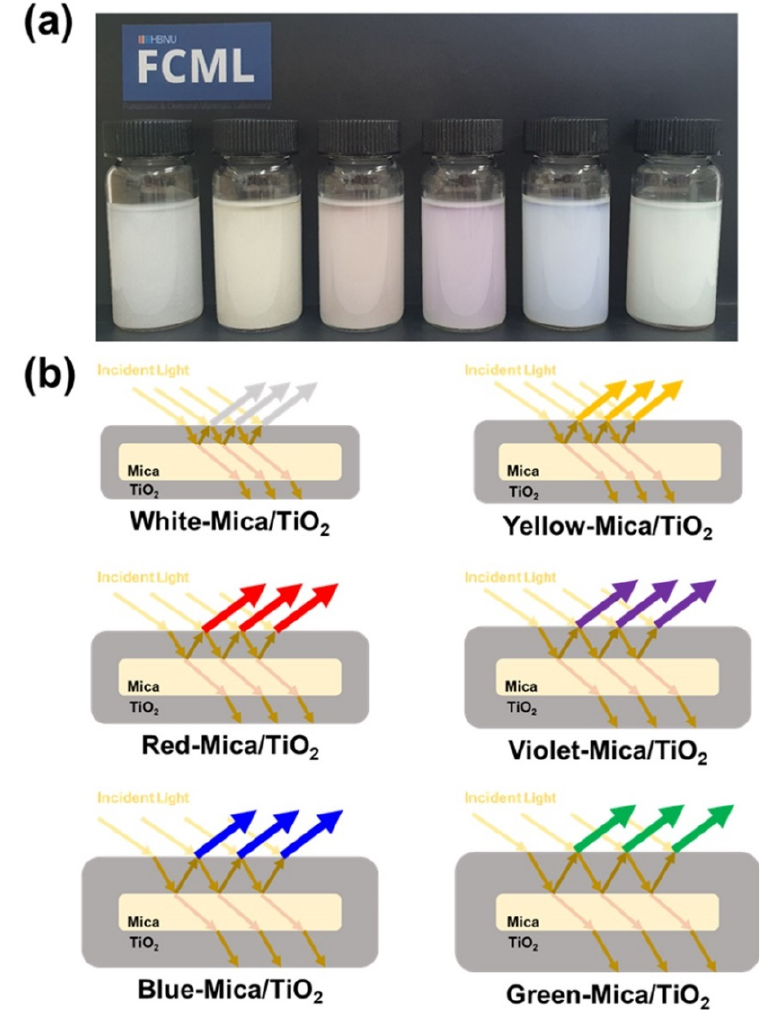
Figure 2. ( a ) Digital photographs of white mica/TiO 2 , yellow mica/TiO 2 , red mica/TiO 2 , violet mica/TiO 2 , blue mica/TiO 2 , and green mica/TiO 2 materials (from left to right) dispersed in EtOH. ( b ) Schematic for the underlying mechanism of the color mica/TiO 2 materials with different colors. The morphologies of the color mica/TiO 2 materials were investigated using